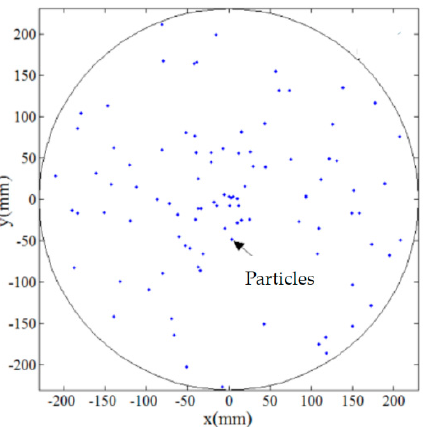
Figure 6. Random distribution of 100 abrasive particles on the lapping plate.